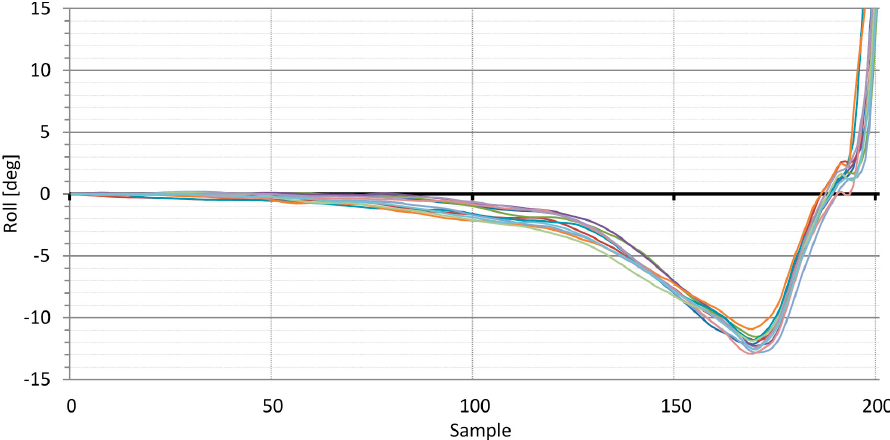
Figure 7. Series of swings performed by a professional golf player. The plots show the head roll in degrees for the last 3.33 s of each swing. The last 200 samples of the swing at a sampling rate of 60 Hz yields an analysis window of 3.33 s.